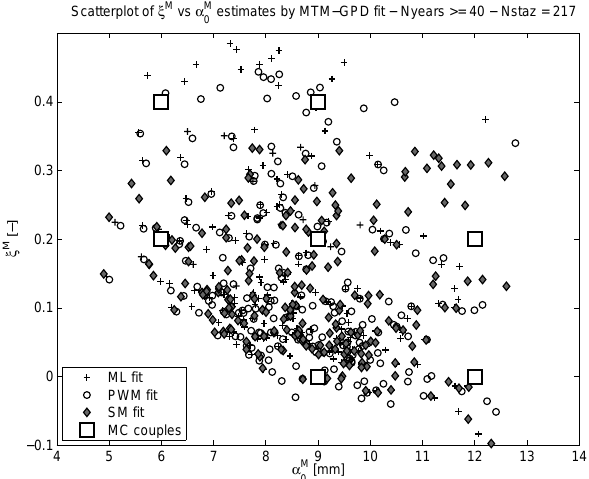
Fig. 5. The scatterplot displays the couples of ( ξ M , α M estimates of GPD parameters for the 217 daily rainfall time series (which are more than 40-yr long) collected by the Sardinian Hy- drological Survey (Italy). Parameters estimates were obtained by applying the MTM within a range of thresholds between 2.5 and 12.5mm: plus signs, circles, and diamonds refer to estimates based on maximum likelihood (ML), probability weighted moments (PWM) and simple moments (SM), respectively. Finally the seven couples of GPD parameters used in Sect. 5 to explore the perfor- mances of the MTM on Monte Carlo samples are drawn with square